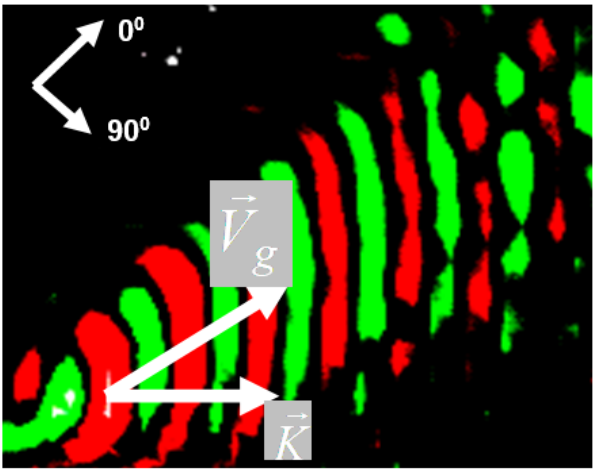
Figure 14. Experimental observation of beam steering in CFRP (( f · D ) = 125): air-coupled a 0 -wave propagates at ( − 45 ◦ ) to fibre direction (0 ◦ ).